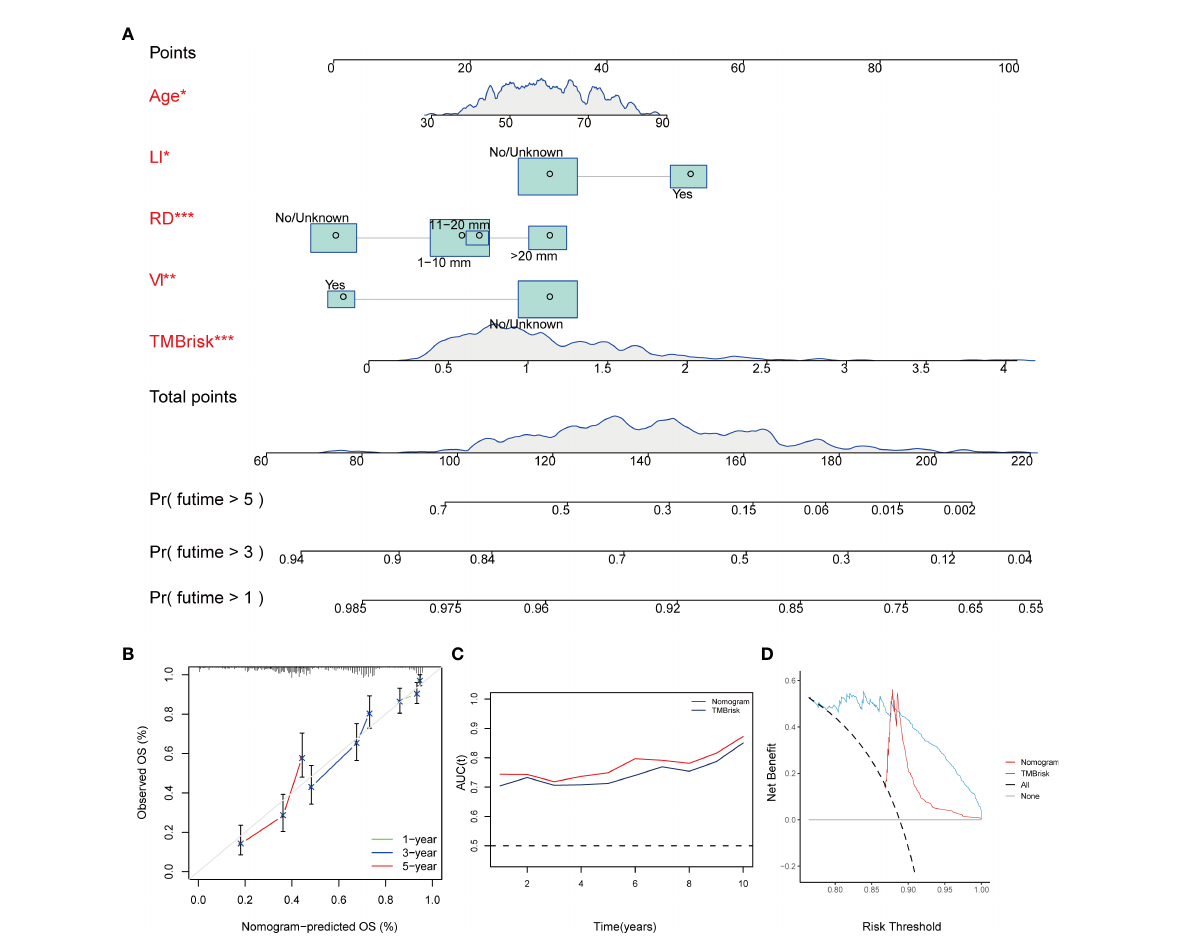
FIGURE 8 Construction and validation of nomogram. (A) Nomogram constructed based on TMBrisk, age, residual disease, venous invasion, and lymphatic invasion as predictive factors to predict 1-, 3-, and 5-year survival probability. (B) Calibration curves for the survival probability at 1, 3, and 5 years. (C) Time-dependent AUC value of the nomogram and TMBrisk in TCGA. (D) DCA curves to evaluate the clinical utility of different decision strategies. *p < 0.05; **p < 0.01; ***p < 0.001. TMB, tumor mutational burden; RD, residual disease; VI, venous invasion; LI, lymphatic invasion; AUC (t), time-dependent AUC; DCA, decision curve